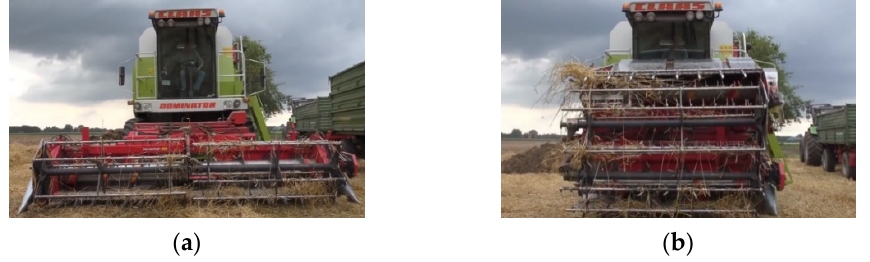
Figure 10. CLASS TUCANO 450 combine harvester. ( a ) Unfold status of the header; ( b ) fold status of the header.